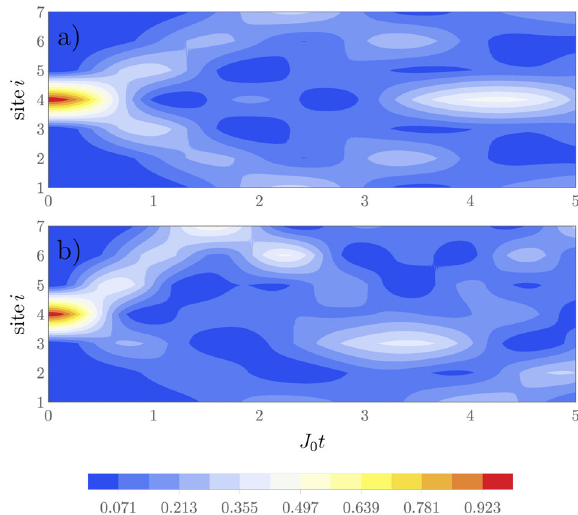
Fig. 3 Time evolution of the impurity. The contour plot presents the average probability for the impurity to be found at the i th-site, h S # function of time, t . The data are for an N = 7 system with an impurity initialized at the center with a) k B Δ T = 0 and b) k B Δ T = 2 ϵ 0 . Here, ϵ 0 is the energy per particle in the thermodynamic limit, k B is the Boltzmann constant, J 0 = α 1 / g , where α 1 is the value of the exchange coef fi cients at T = 0 and g is the interaction strength. In panel a), the impurity probability evolves symmetrically with respect to the edges as the system is homogeneous. In panel b), the presence of the temperature difference across the system leads to a directional motion of the impurity towards the high-temperature edge. Red (blue) colors correspond to higher (lower) probabilities. All presented quantities are dimensionless.